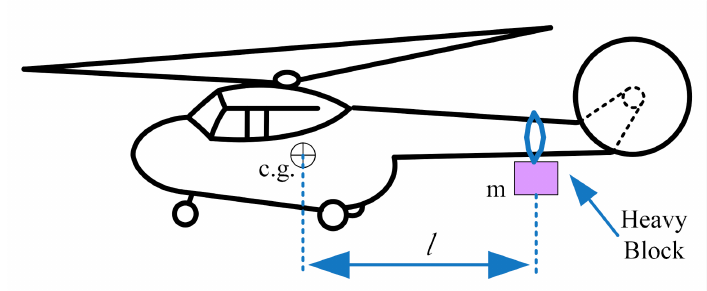
Figure 6. The structure diagram of block dropping system.